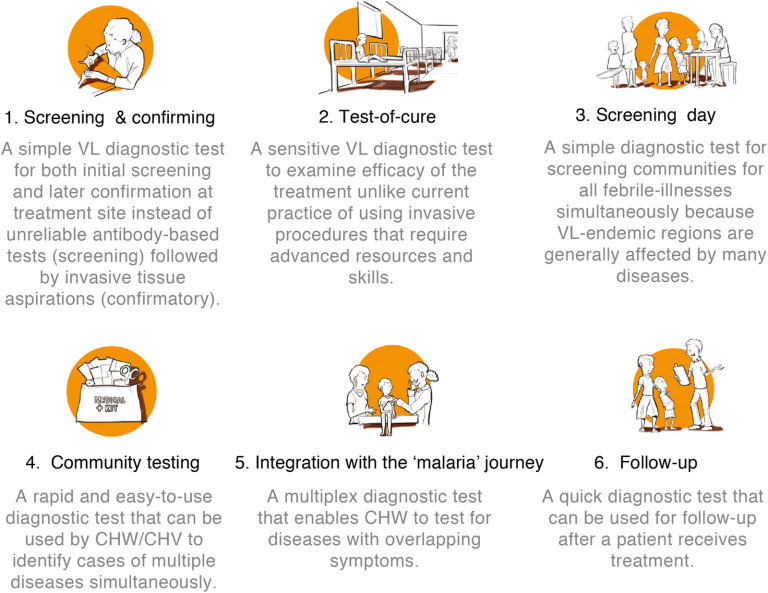
Six Scenarios That Elaborate on the Scope of Application of a New Point-of-Care Diagnostic TestAbbreviations: CHV, community health volunteer; CHW, community health worker; VL, visceral leishmaniasis.